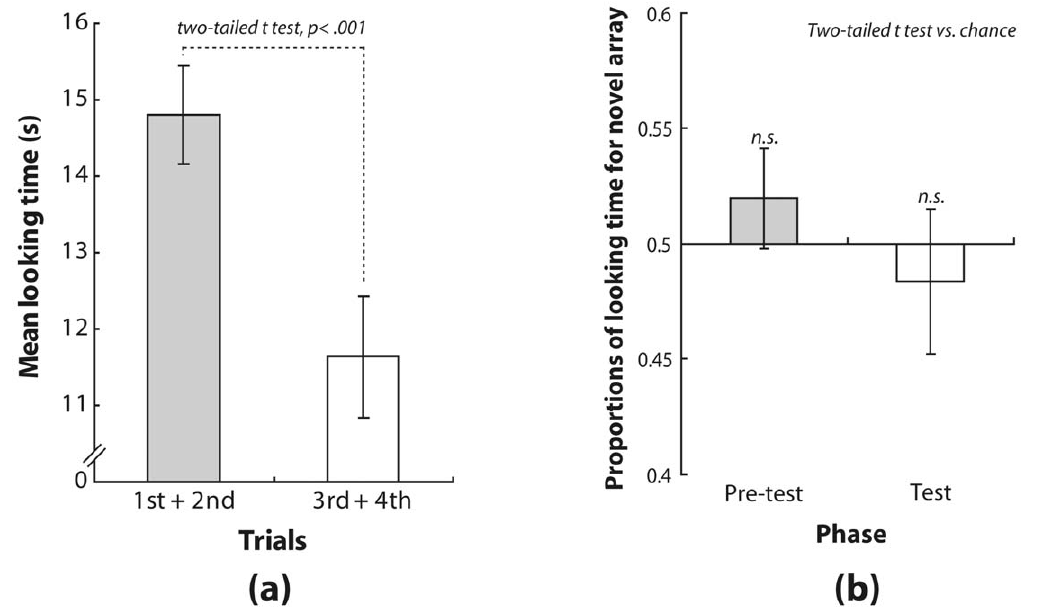
Figure 3. Results of Experiment 2. (a) Mean durations of looking time for the first and second halves of trials in the familiarization phase. Error bars denote SEM (N=24). (b) The left and right bars represent mean proportions of time spent looking at the novel array in the pre-test and test phases, respectively. Error bars denote SEM (N=24).